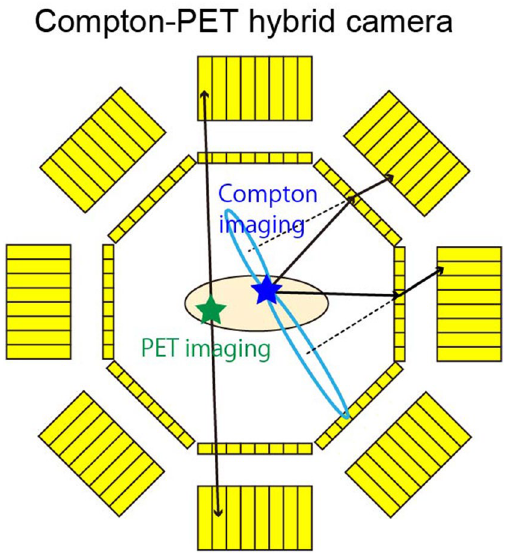
Figure 1. Concept of the Compton-PET hybrid camera. The PET tracers are visualized using coincidence detection of annihilation gamma rays through opposing absorbers. The SPECT tracers are visualized using coincidence detection of a Compton-scattered gamma ray (in a scatterer) and a fully absorbed gamma ray (in an absorber). Green and blue stars represent PET and SPECT tracers, respectively. The solid black lines represent two gamma rays, here scattered by separate scatterers (thin yellow boxes) before being absorbed in separate absorbers (thick yellow boxes). The dashed lines represent the axes of the two Compton cones, and the blue ovals represent their bases. The figure was created using the software (Adobe Illustrator, Illustrator CC 24, https:// www. adobe. com/ produ cts/ illus trator.